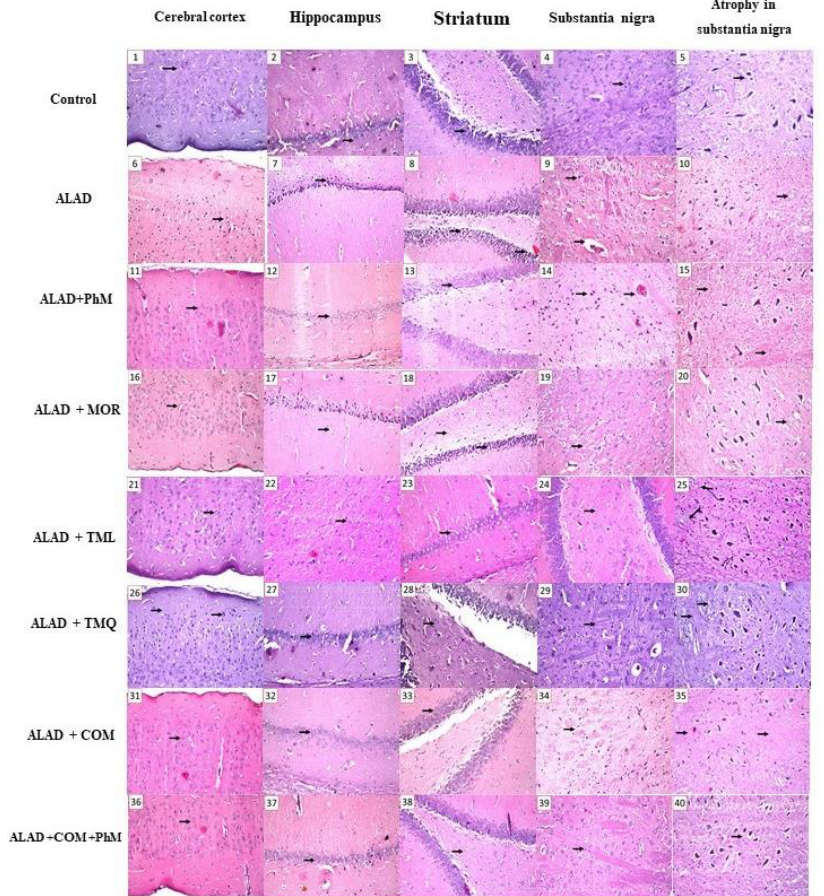
Figure 2. Photomicrographs of brain sections stained by Hematoxylin and Eosin (magnification 40X). In control group, there was no histopathological alteration in the cerebral cortex, hippocampus, striatum, and substantia nigra ( Inserts 1–5 ). In ALAD group, there were nuclear pyknosis and degeneration in the neuronal cells of the cerebral cortex ( Insert 6 ), subiculum and fascia dentate of the hippocampus ( Inserts 7,8 ). Focal eosinophilic plagues were detected in the striatum ( Insert 9 ). The substantia nigra showed atrophy in the neuronal cells ( Insert 10 ). In ALAD + PhM group, the cerebral cortex and hippocampus showed no histopathological alteration ( Inserts 11–13 ). Nuclear pyknosis and degeneration were recorded in the neurons of the striatum with congestion in the blood vessel ( Insert 14 ). The substantia nigra showed atrophy in some of the neuronal cells ( Insert 15 ). In ALAD + MOR group, there was no histopathological alteration in the cerebral cortex ( Insert 16 ). Nuclear pyknosis and degeneration were observed in some neuronal cells of the subiculum as well as the fascia dentate in the hippocampus ( Inserts 17,18 ). The striatum showed intracellular oedema in the neuronal cells ( Insert 19 ). Mild atrophy was detected in the cells of substantia nigra ( Insert 20 ). In ALAD + TML group, nuclear pyknosis was observed in the neurons of the cerebral cortex and striatum while the hippocampus was intact ( Inserts 21–24 ). Diffuse gliosis was detected in substantia nigra (Insert 25). In ALAD + TMQ group, the cerebral cortex showed focal nuclear pyknosis and degeneration in the neuronal cells ( Insert 26 ). There was no histopathological alteration in the hippocampus as well as in the striatum ( Inserts 27–29 ). Atrophy was detected in some neurons of the substantia nigra ( Insert 30 ). In ALAD + COM group, the cerebral cortex and hippocampus (subiculum, fascia dentate and hilus) showed normal histological structure ( Inserts 31–33 ). Focal fine plagues were detected in striatum ( Insert 33 ). There was atrophy in some neuronal cells in the substantia nigra ( Insert 35 ). In ALAD + COM + PhM group, there was no histopathological alteration in the cerebral cortex, hippocampus (subiculum, fascia dentate and hilus), striatum and substantia nigra ( Insert 36–40 ). [The data of the effect of MOR, TML and TMQ on the control is not shown as it is not